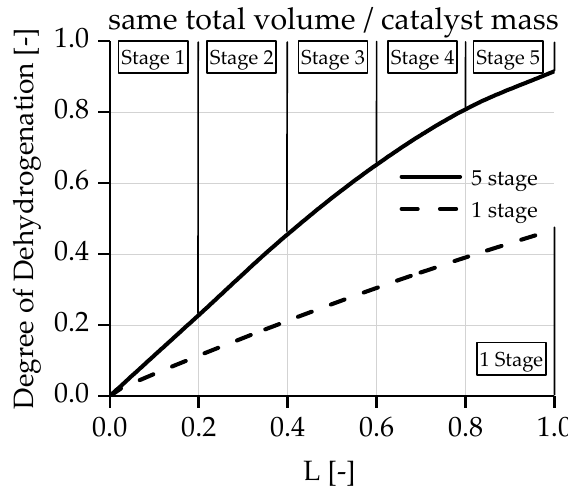
Figure 9. Dehydration degree over the reactor length with different number of separation stages.